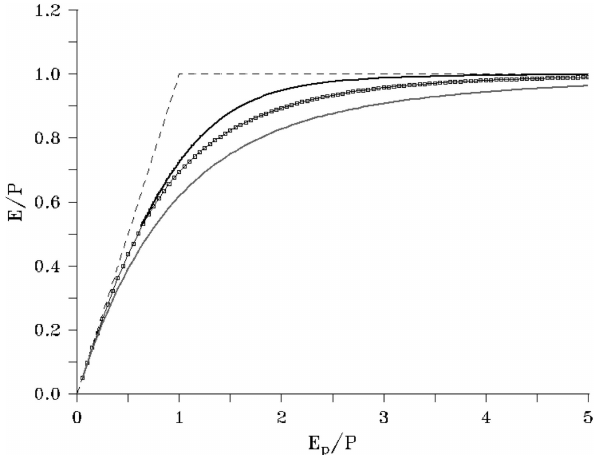
Figure 3. Prototype Budyko curves for the baseline prototype, i.e., η = 4, in the formulation of runoff (thick black), for Eq. (15) for η = 2 (gray), and Budyko’s empirical formula (squares). The dashed lines are the energy- and water-limited